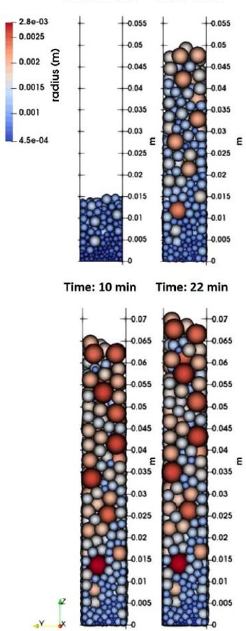
Fig. 5 Particle profiles at different swelling time.